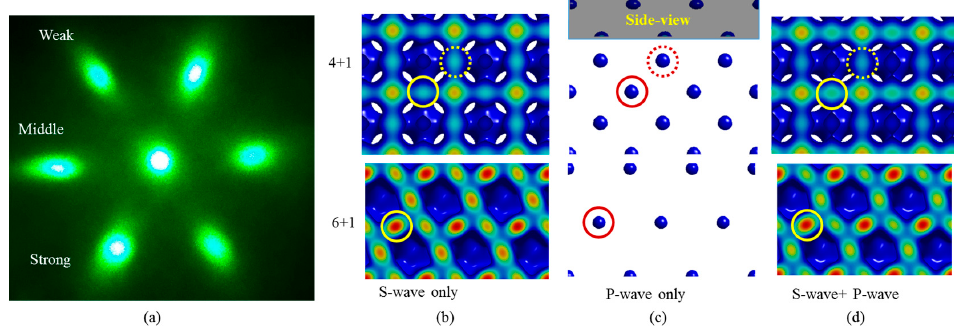
Figure 5. ( a ) Diffraction pattern from fabricated 3D photonic crystal template in SU-8 using 532 nm laser; ( b ) top-view of simulated interference among pure s-wave side beams plus the central circularly polarized beam; ( c ) among pure p-wave side beams plus the central circularly polarized beam; ( d ) among side beams with both s- and p-waves plus the central circularly polarized beam. Interference patterns generated with 4 + 1 and 6 + 1 configurations are shown in top and bottom row in (b,c,d), respectively. Circles indicate the corresponding locations of high intensity spots. Dotted circles indicate the spots located at the bottom as shown in the side view in the insert in (c).